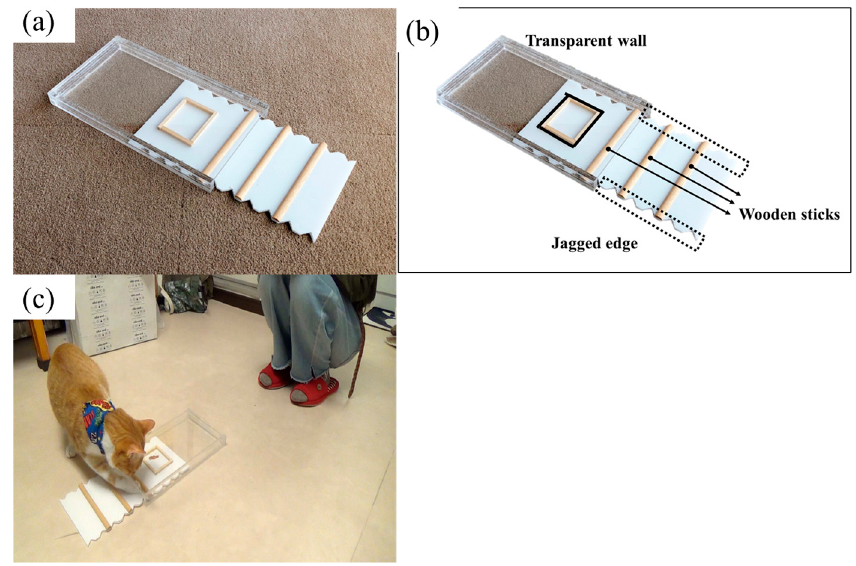
Figure 1. The drawer task apparatus (Experiment 1). ( a ) The apparatus in the “open” position; ( b ) Names of three parts of the apparatus; ( c ) An example of a trial.